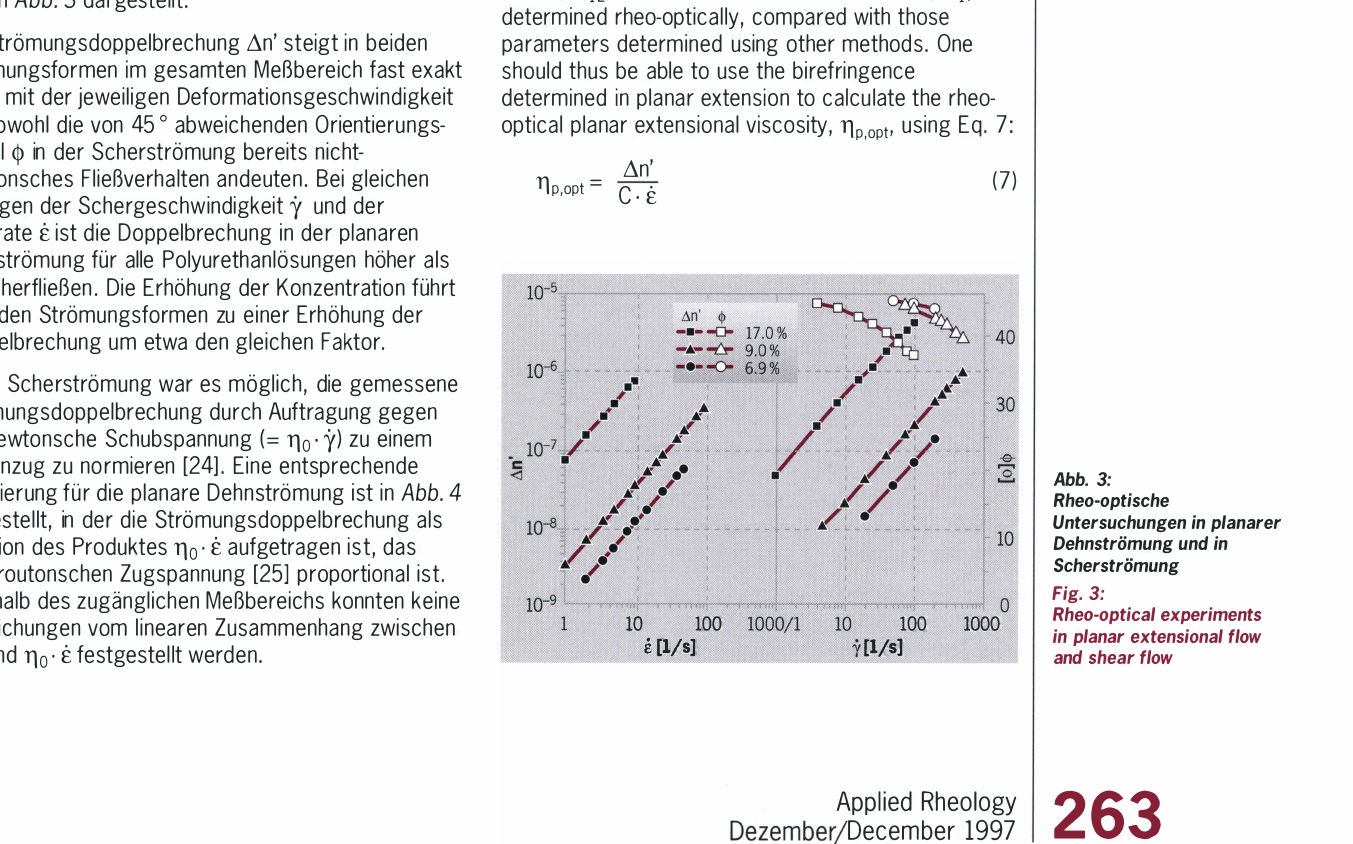
Fig. 3: Rhea-optical experiments in planar extensional flow and shear flow